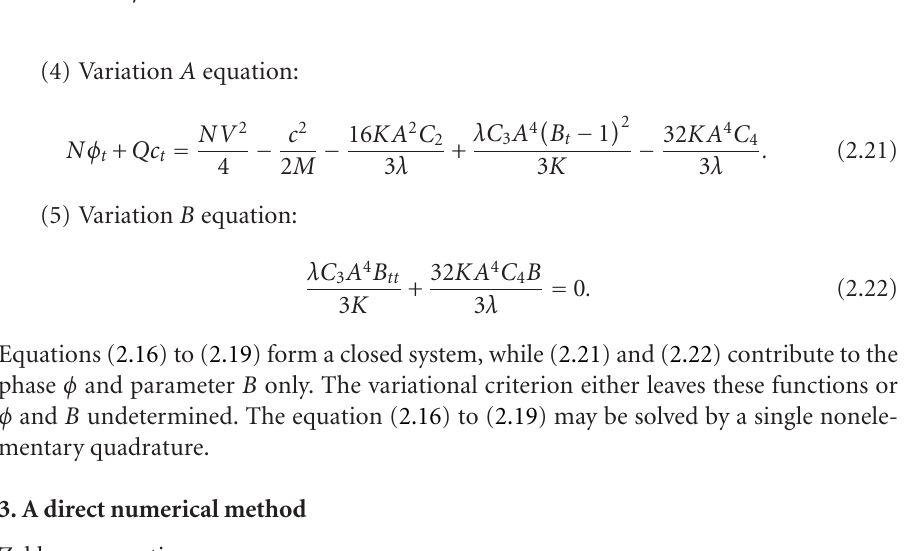
Figure 3.1. Numerical solution to the Zakharov equations in static limit. The initial conditions are A = 1, α = 1 . 2, β = c = 0 . 1, and V =